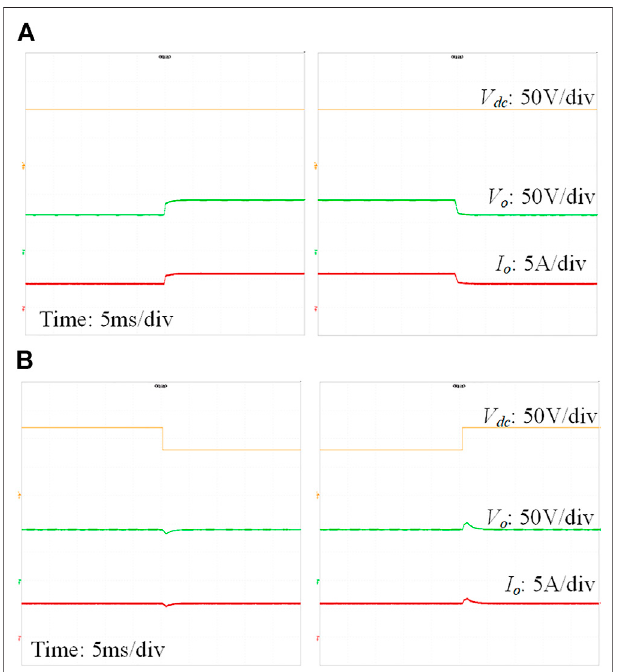
FIGURE 13 | Dynamic waveforms of the single DAB converter with CTPS: (A) when the load steps between half load and full load; (B) when the input voltage steps between 80% and 120% rated voltage.